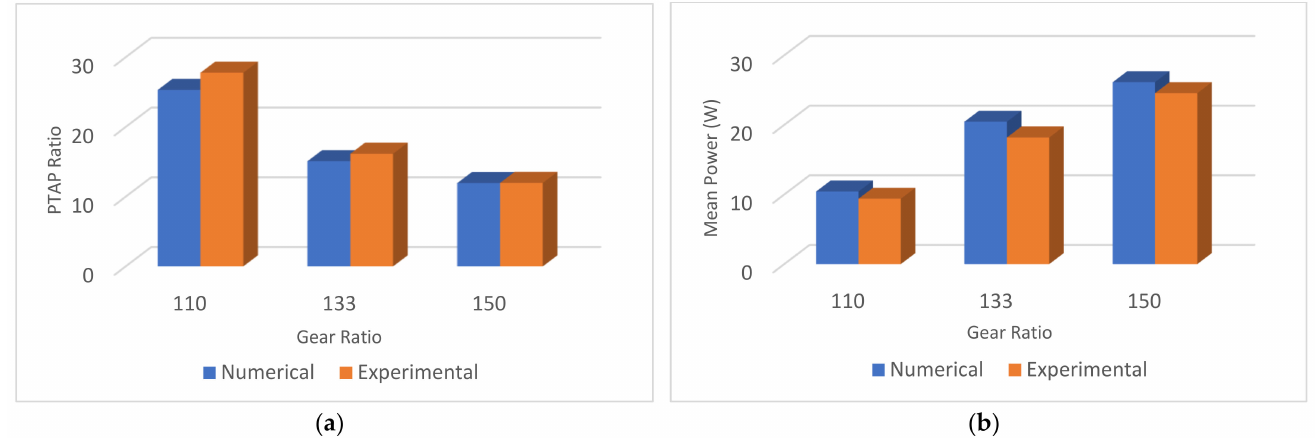
Figure 12. Comparisons between numerical and experimental simulation results for ( a ) the PTAP ratio and ( b ) mean